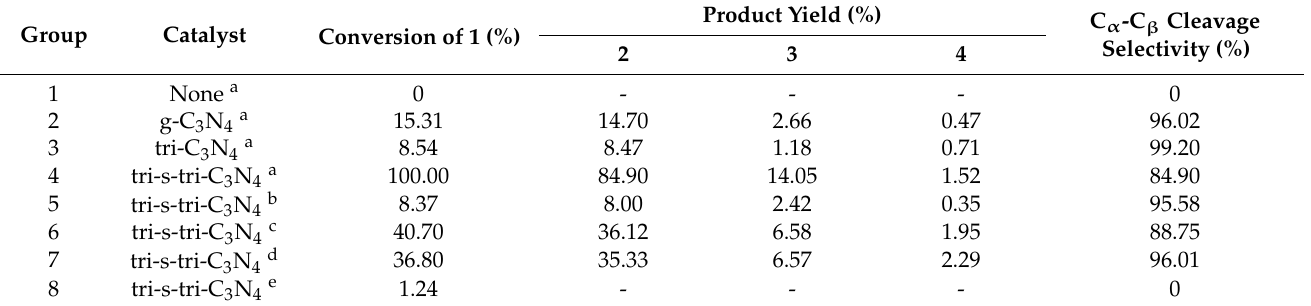
Figure 10. Photocatalytic conversion of ML using tri-s-tri-C 3 N 4 in water–acetonitrile solvent and comparison chart of main product yield.